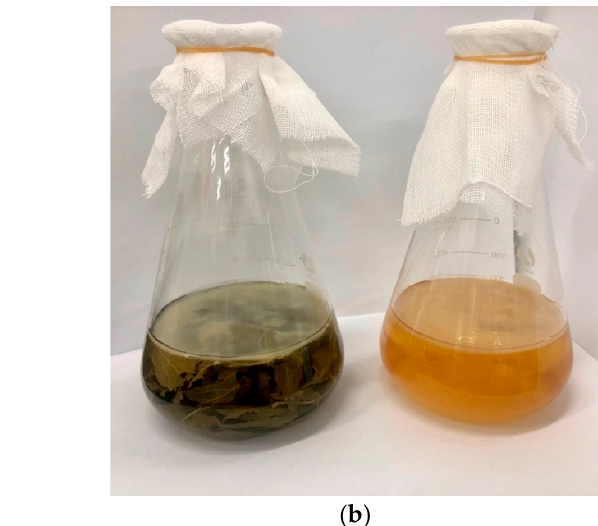
Figure 1. The appearance of kombucha beverages fermentation with or without tea residues. ( a ) kombucha from vine tea with or without tea residues; ( b ) kombucha from sweet tea with or without tea residues.